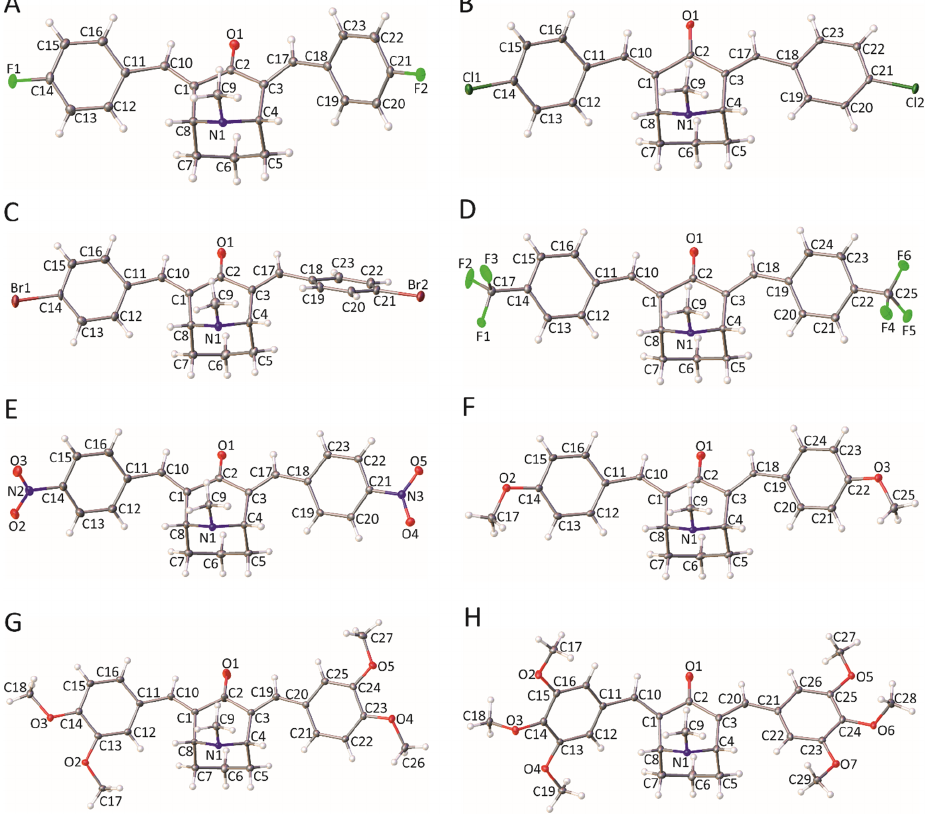
Figure 2. The molecular structure of compounds ( A ) 3 , ( B ) 4 , ( C ) 5 , ( D ) 6 , ( E ) 7 , ( F ) 8 , ( G ) 10 , and ( H ) 11 . Displacement ellipsoids are drawn at the 30% probability level. For clarity, for ( D ) compound 6 only, the more populated location of the disordered fluorine atoms, and, for ( E ) only, one of the total two molecules of compound 7 present in the asymmetric unit are shown.